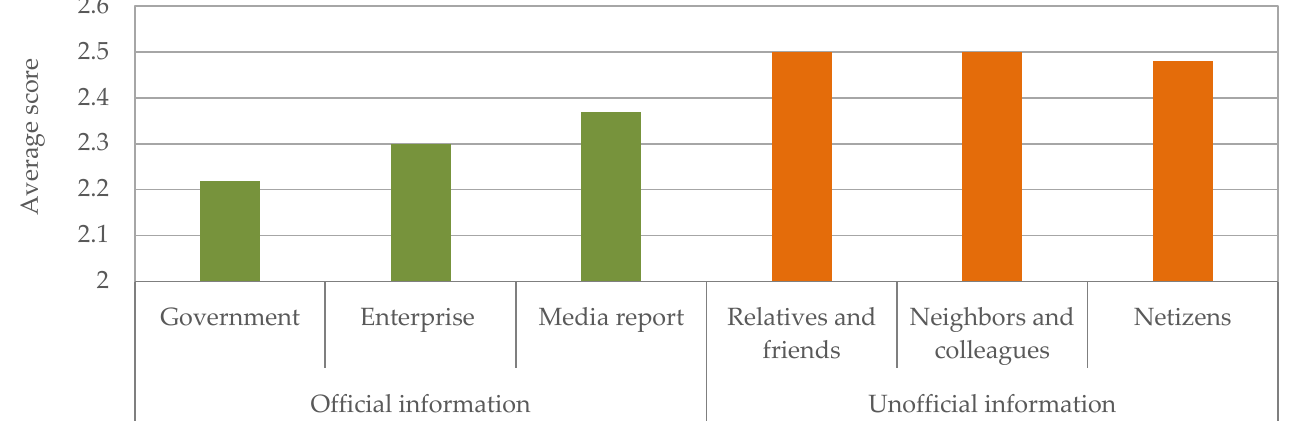
Figure 5. Information frequency scores of HPWHs obtained by consumers.